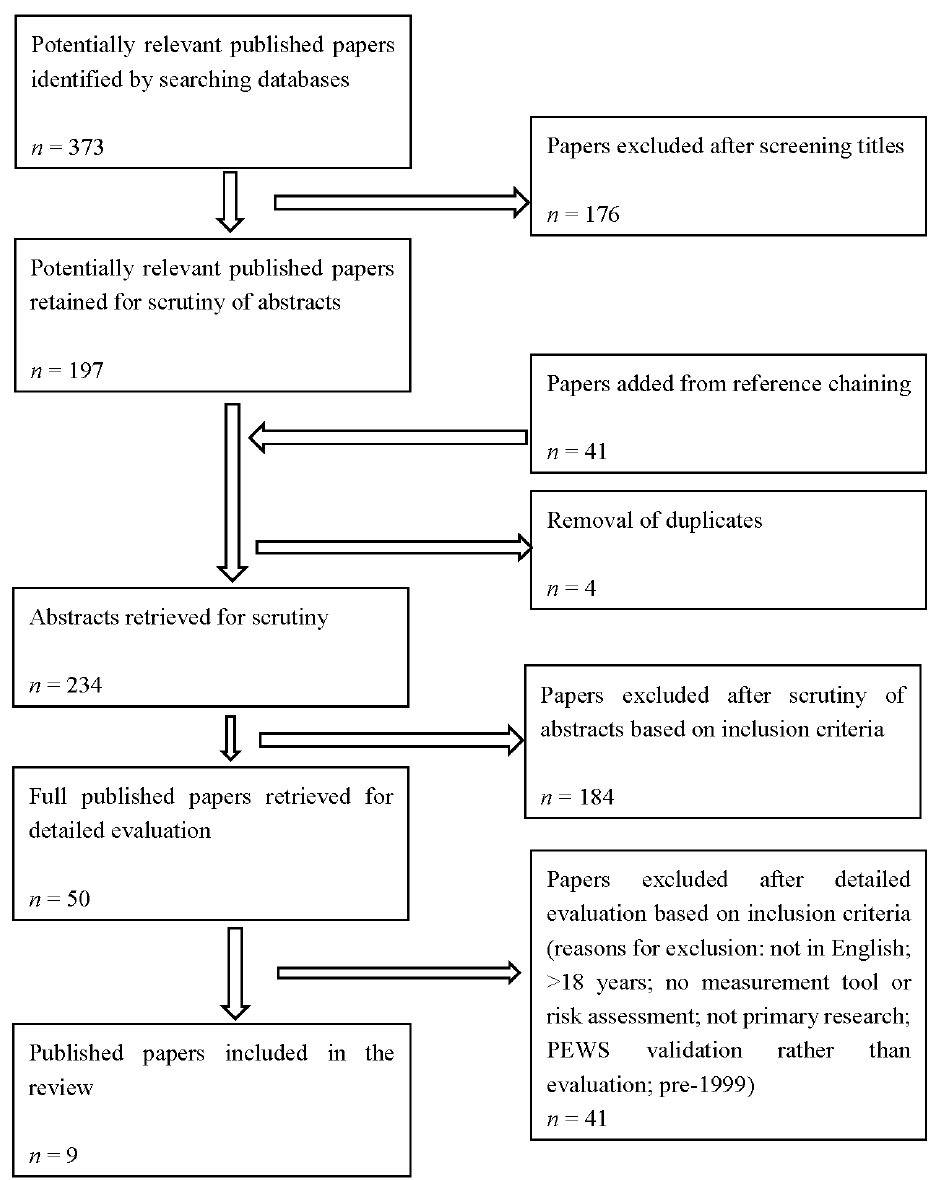
Figure 1. PRISMA flow diagram of screening process.